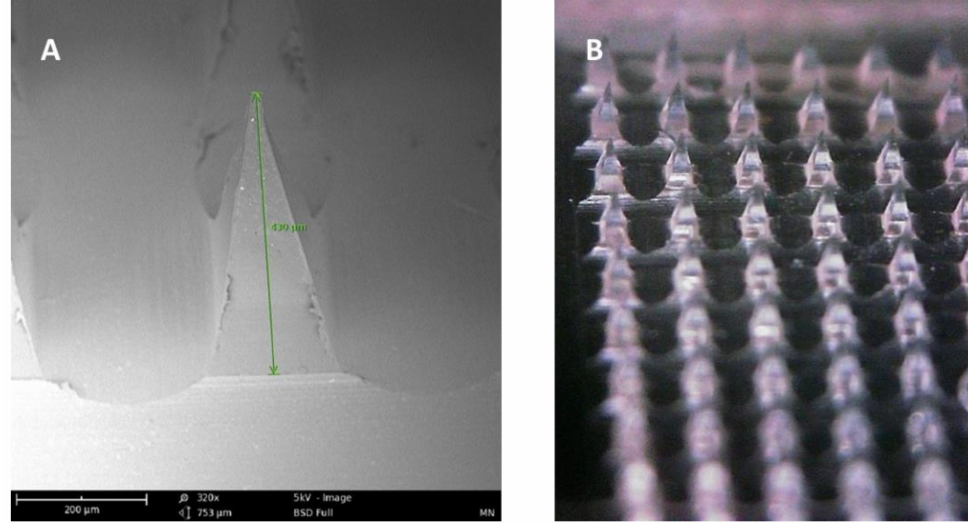
Figure 3. ( A ) SEM image of a dissolving polymeric microneedle (size: 430 µ m, scale 200 µ m). ( B ) Optical microscope image of the same microneedle array